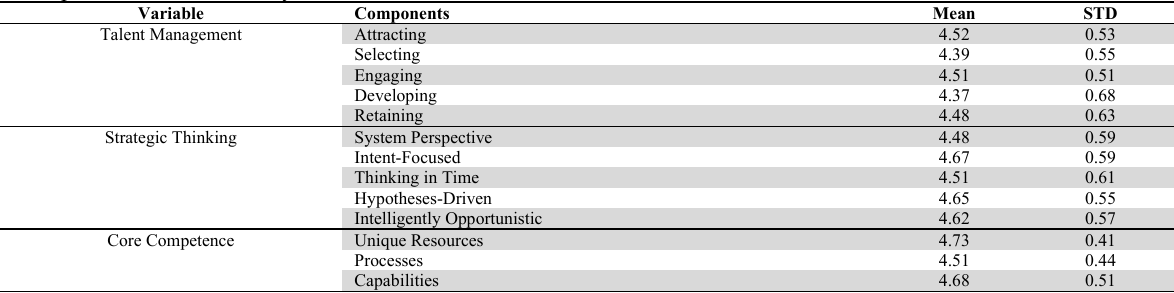
Descriptive Statistics for Study Variables